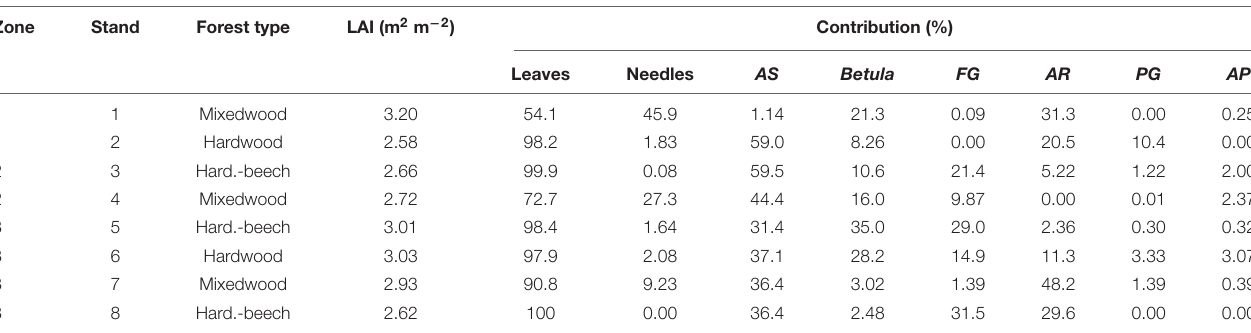
TABLE 2 | Mean tree species contributions to total litterfall mass in each stand in 2018.